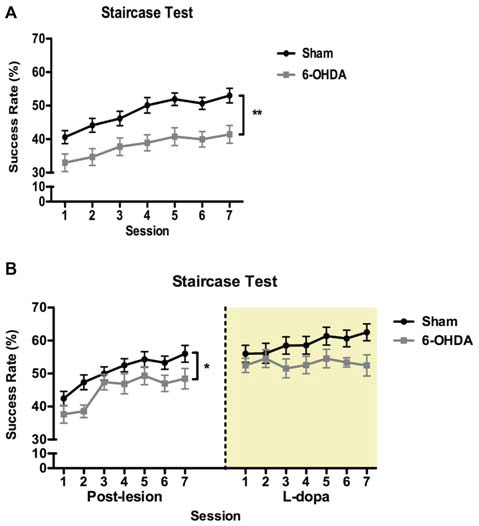
Effect of 6-OHDA lesions and levodopa (LD) treatment on skilled forelimb motor function. (A) Longitudinal post-lesion assessment of staircase. 6-OHDA, n = 30; sham, n = 28. (B) Reassessment of motor performance during LD treatment in a subset of 6-OHDA (n = 11) and sham (n = 20) animals tested in (A). Data presented as mean ± SEM. *p < 0.05; **p < 0.01.